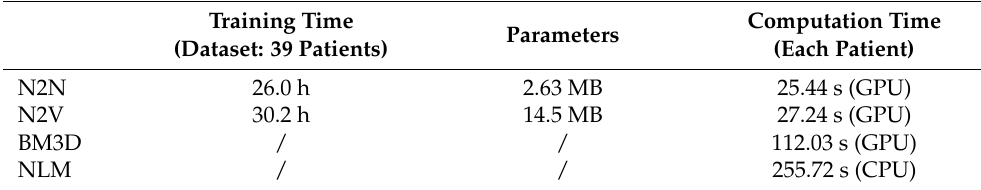
Table 2. Computation time for N2N, N2V, BM3D and NLM.